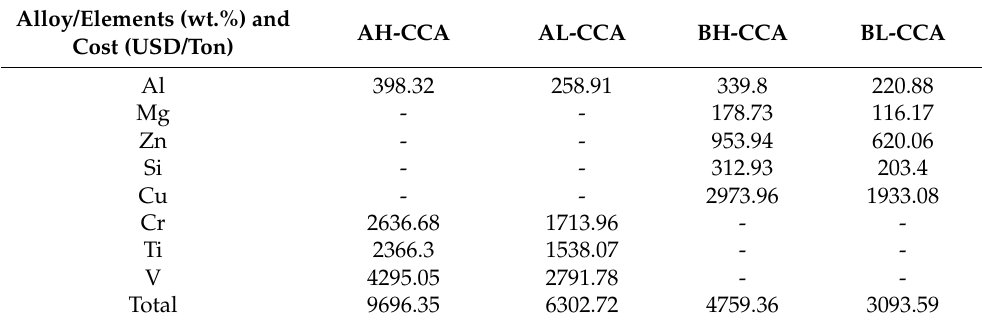
Table 2. Comparison of cost for CCAs produced by high- and low-quality scrap. Alloy/Elements (wt.%)